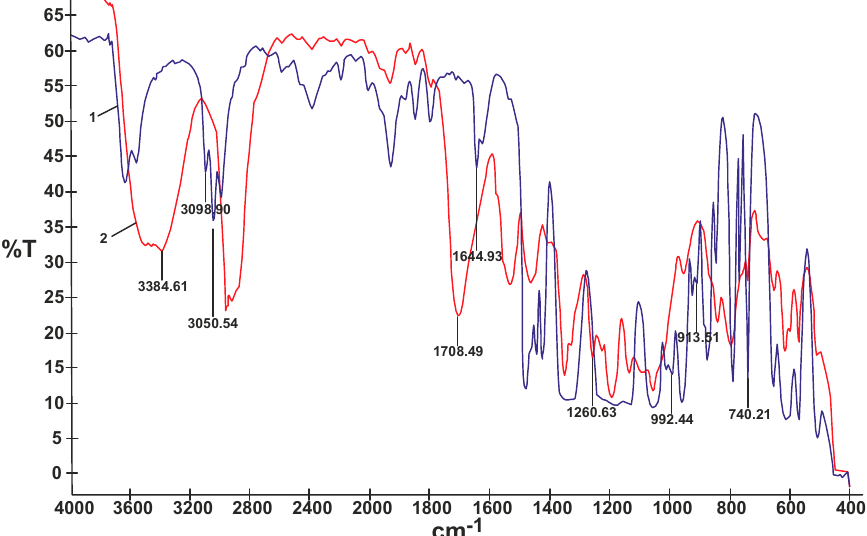
Figure 6. Comparison of FTIR spectra of reactive IL 3 (1) and UV-cured composite M prepared with that reactive IL 3 (2).